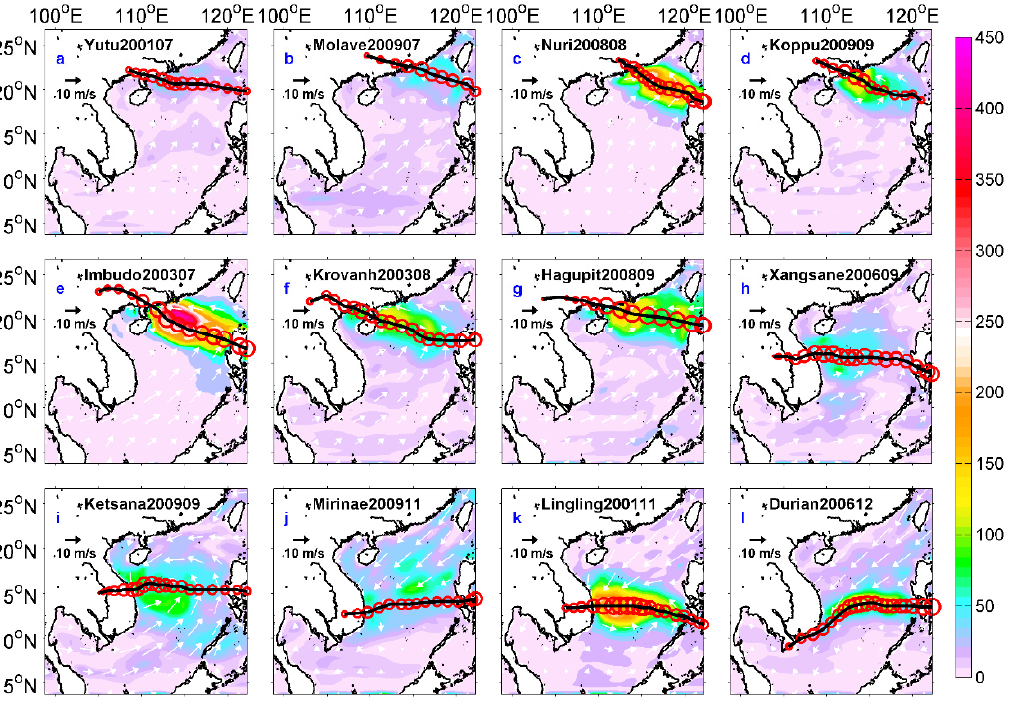
Figure 5. Typhoon tracks and 3-day averaged NIWS (unit in 10 − 3 N / m 2 ), filtered from wind stress of Climate Forecast System Reanalysis (CFSR) data when Typhoons Yutu ( a ), Molave ( b ), Nuri ( c ), Koppu ( d ), Imbudo ( e ), Krovanh ( f ), Hagupit ( g ), Xangsane ( h ), Ketsana ( i ), Mirinae ( j ), Lingling ( k ), and Durian ( l ) passed over the SCS. The white arrows are the background wind speeds.